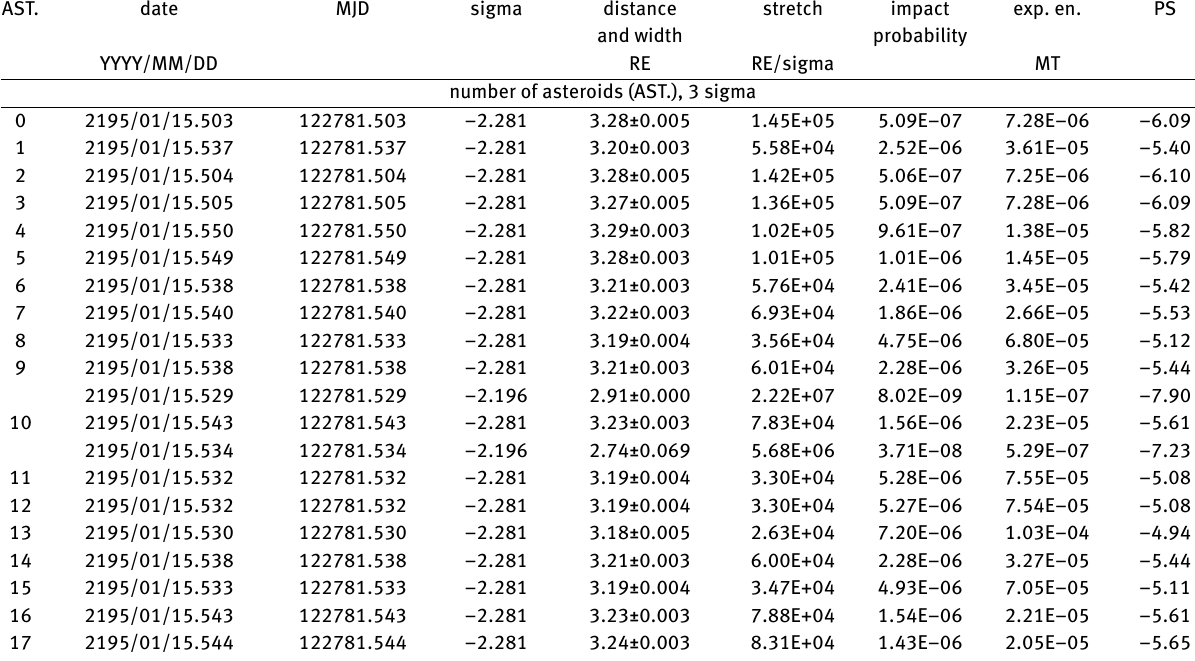
Table 3. The asteroid 2001BB16. The LOV 1 method. The dependence of computed impact risk on number of perturbing massive asteroids (in column AST.) for computed non-gravitational parameter A 2=(34.551±7.384)·10 −14 au/d 2 . The JPL DE431 Solar System model is used.